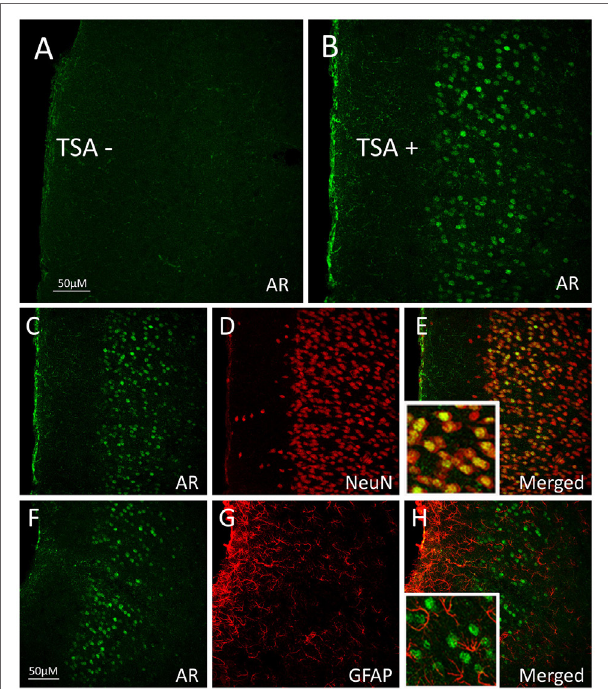
FiGURe 3 | Androgen receptor (AR), neuronal nuclei (NeuN, neuronal marker), and glial fibrillary acidic protein (GFAP; glial marker) immunoreactivity (ir) in the medial prefrontal cortex (mPFC) of adult male rats. (A,B) Pseudocolored confocal photomicrographs of androgen receptor immunoreactivity (AR­ir) in coronal hemisections of the mPFC (A) without tyramide signal amplification (TSA − ) and (B) with tyramide signal amplification (TSA + ). TSA­enhanced detection of AR in the mPFC of male rats. (C–e) Confocal photomicrographs of mPFC with (C) AR­ir cells (green), (D) NeuN­ir cells (red), and (e) AR­ir and NeuN­ir cells merged. Cells that co­express AR­ir and NeuN­ir appear orange–yellow, suggesting that AR is primarily expressed in neurons. (F–H) Confocal photomicrographs of (F) AR­ir cells (green), (G) GFAP­ir cells (red), and (H) AR­ir and GFAP­ir cells merged. AR­ir is not co­expressed with GFAP. Adapted from Ref. (33); Reprinted by permission of SAGE